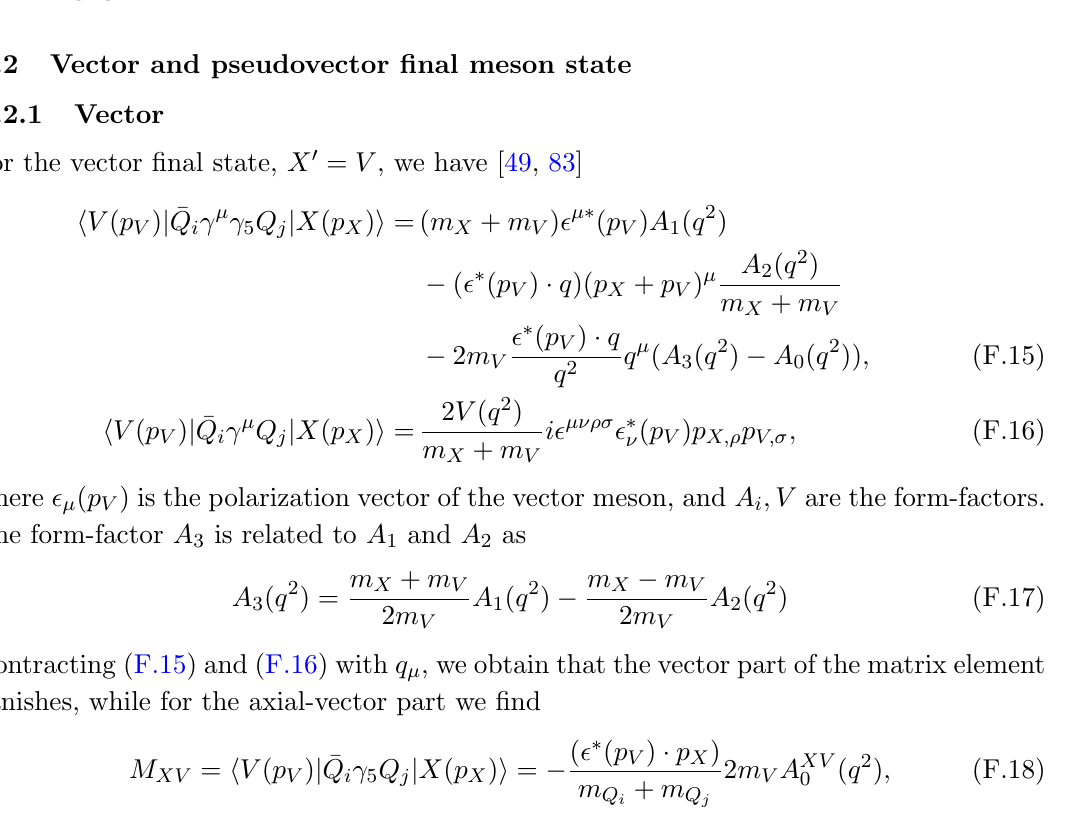
Table 9 . Values of the parameters in the form-factor (F.14) for B = B + , ~ S = K (cid:3) 0 We used